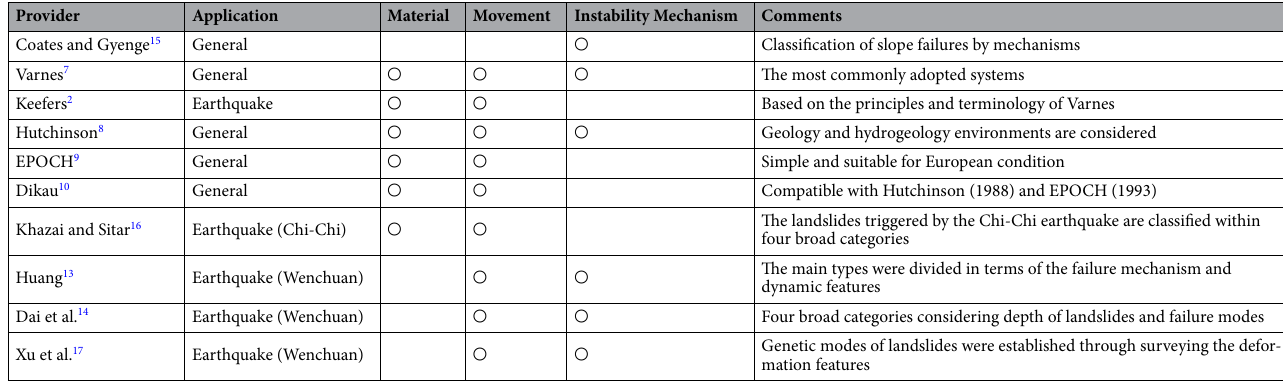
Table 1. Summary of landslide classification systems. Items from column 3 to 5 are classification basis, the presence is symbolized by a